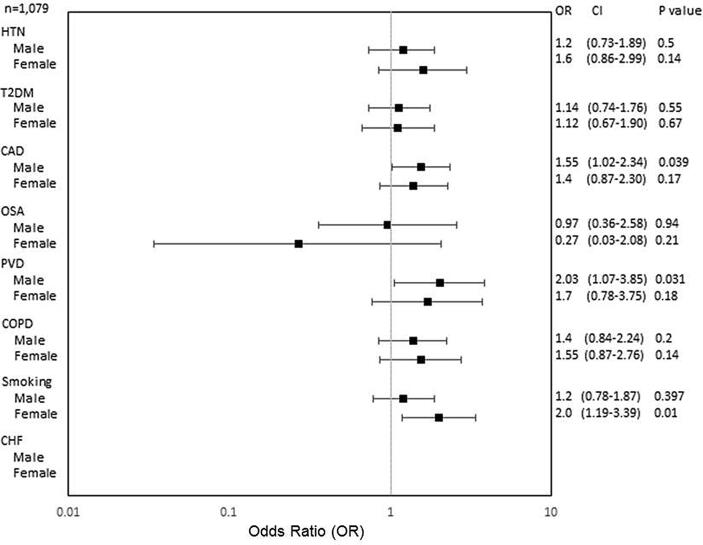
Impact of age-adjusted AF risk factors on stroke in Non-Hispanic Whites (NHWs). Abbreviations as in Fig. 2a.